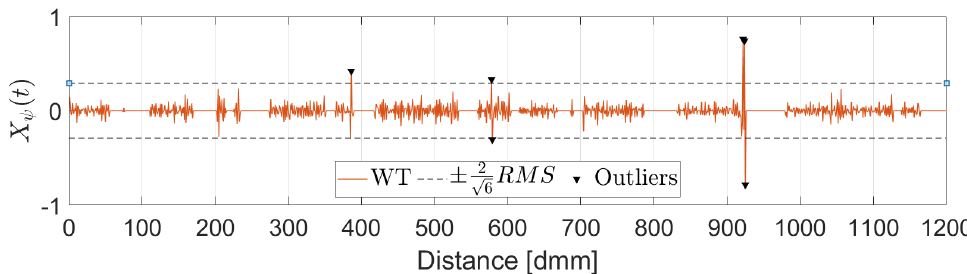
Figure 5. Outlier Detection. Wavelet Transformation.